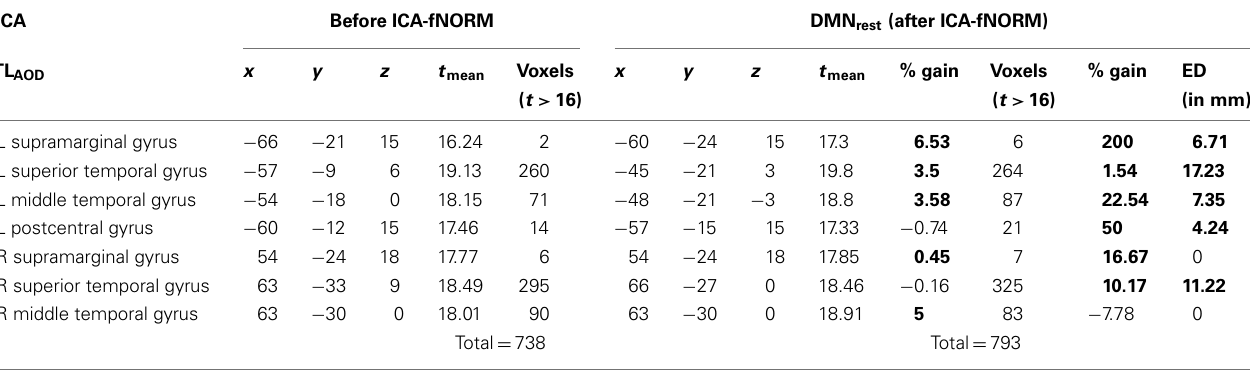
Table 3 |Activation labels and other attributes estimated using a higher threshold ( t > 16) for t -maps corresponding to ICA-fNORM using DMN rest